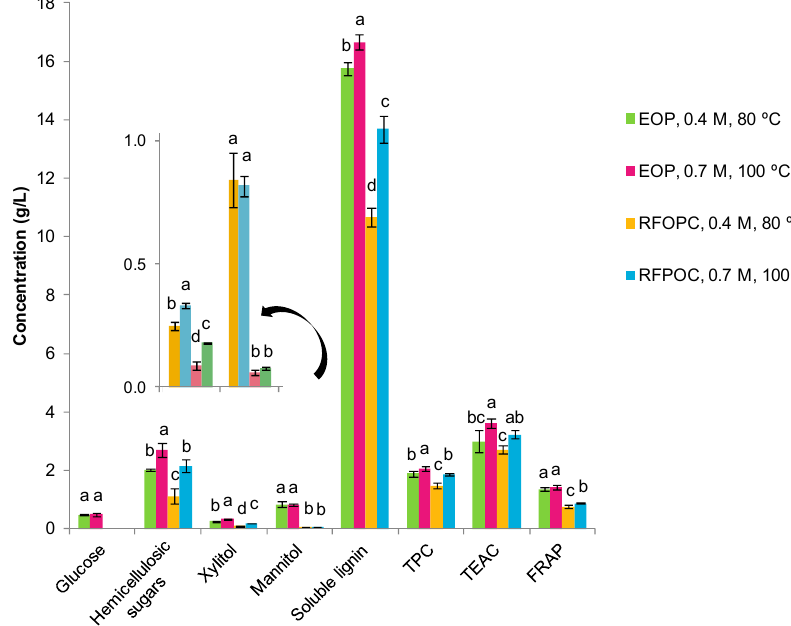
Figure 7. Content of sugar, sugar alcohols, and soluble lignin (g/L), total phenolic content (g gallic acid equivalents/L) and antioxidant activity (g Trolox equivalents/L) of the alkaline extracts obtained from the extracted olive pomace (EOP) and the residual fraction from olive pit cleaning (RFOPC). For each component, different lowercase letters indicate significant differences between the samples ( p < 0.05).